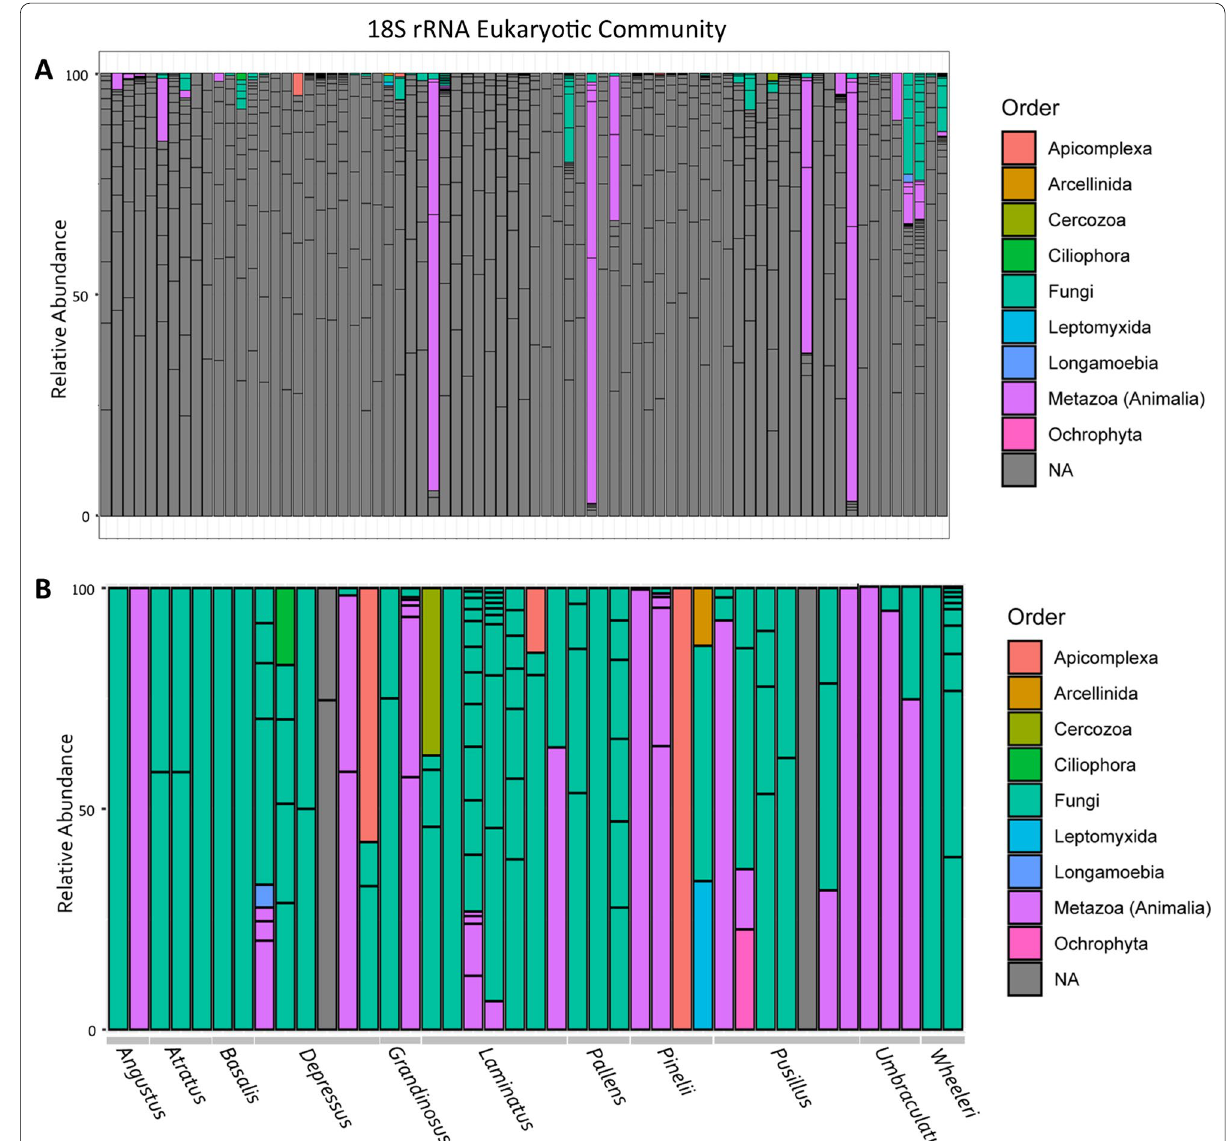
Fig. 2 Microbial eukaryotic communities (18S rRNA) associated with turtle ants. A Stacked barplot showing the relative abundance of eukaryote order composition (18S rRNA) of each individual sample (column). Unclassified orders are represented in gray. B Filtered stacked barplots showing the relative abundance eukaryote order composition (18S rRNA) of each individual sample (column) with the host species group denoted along the